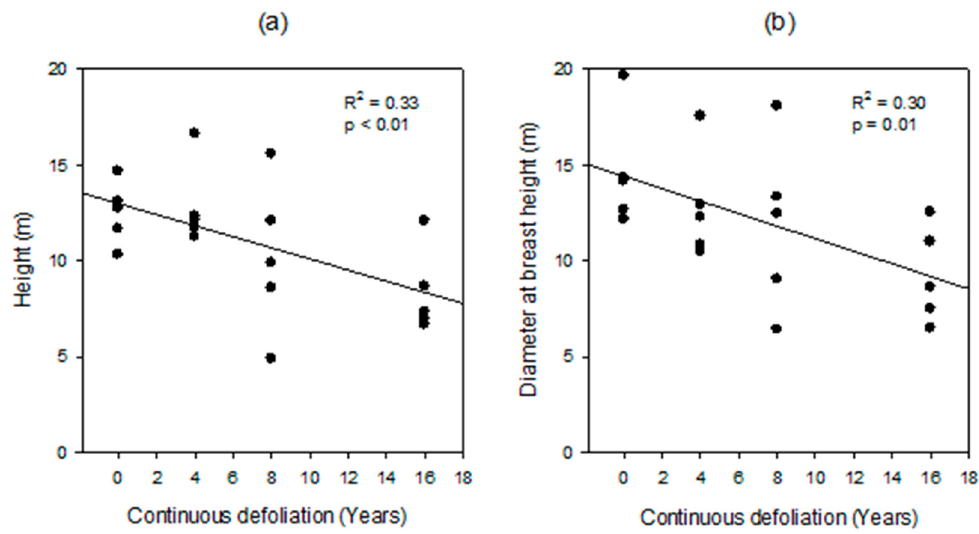
Figure 4. Linear regression of host overstory tree structure (dependent variables) by years of continuous spruce budworm defoliation (independent variable) from 1993–2008 in boreal mixedwood forest near Warren, Ontario: ( a ) Host tree height (Ht); and ( b ) Diameter at breast height (DBH). Linear regression showed years of continuous defoliation significantly predicted host tree height ( R 2 = 0.33, F 3,17 = 8.84, p < 0.01) and diameter at breast height ( R 2 = 0.30, F 3,17 = 7.81, p = 0.01). The equations of the regression lines were Ht = − 0.29 (Continuous defoliation) +13.00 and DBH = − 0.33 (Continuous defoliation) +14.41, respectively. The coefficient estimates with SEM for host tree height and diameter at breast height were − 0.29 ± 0.10, 13.00 ± 0.89 and − 0.33 ± 0.12, 14.41 ± 1.07, respectively.